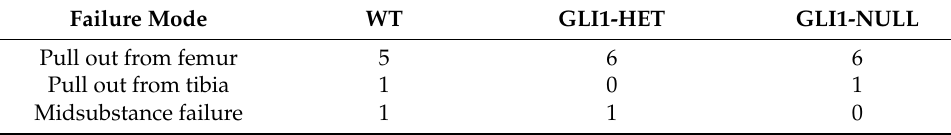
Figure 2. Biomechanical testing results of wild-type, GLI1-HET and GLI1-NULL mice at 4 weeks after ACLR. ( A ) The failure force in the GLI1-NULL group was significantly lower than the GLI1-HET or WT counterparts at 4 weeks after surgery. ( B ) Stiffness was comparable among groups. Values are presented as mean ± SD. *, p < 0.05. Table 1. Failure modes of all specimens ( N = 7/group).